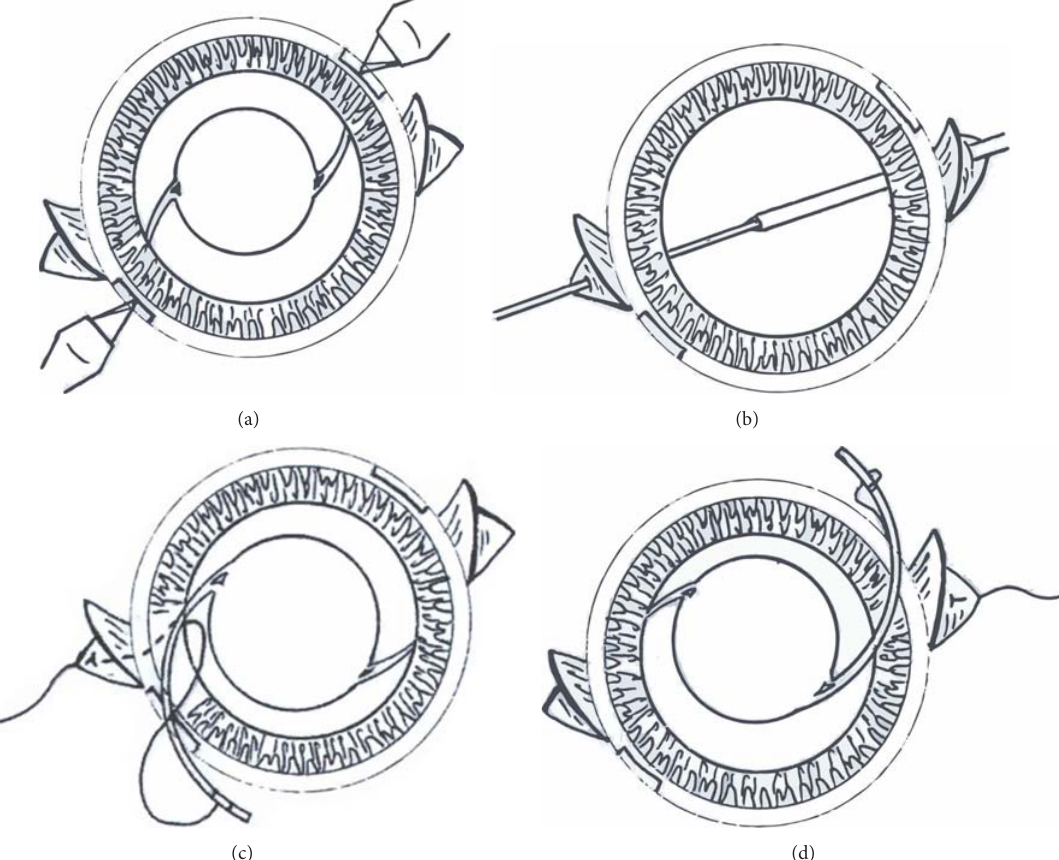
Figure 1: Drawing images of in situ refixation technique. (a) Bilimbal incision was made on the nearest axis of the dislocated haptics. (b) The suture needle was inserted under the two triangular partial thickness sclera flaps. (c) One haptics was externalized through the limbal incision and one of the cut suture thread ends was tied to the haptics. (d) The other haptics was tied with the same procedure to that in